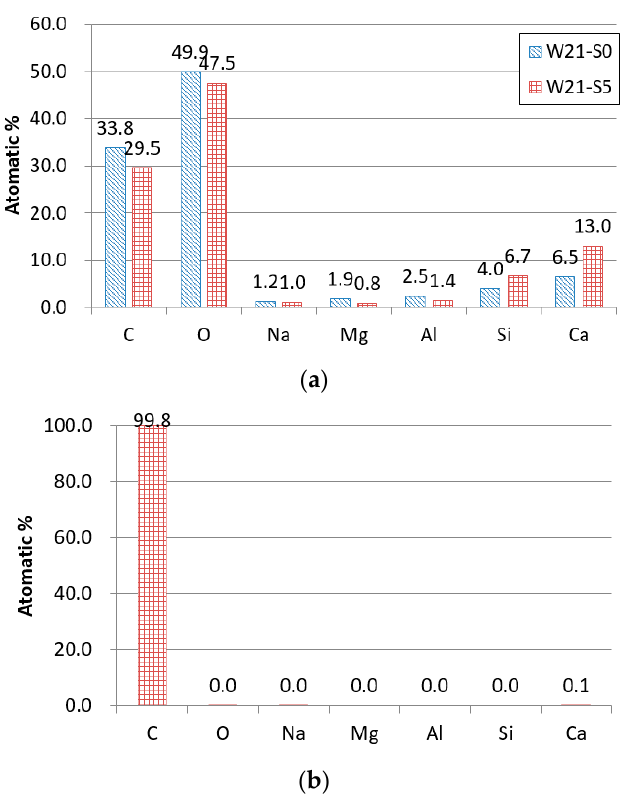
Figure 12. Chemical compositions: ( a ) positions a (W21-S0 specimen) and b-1 (W21-S5 specimen); ( b ) position b-2.